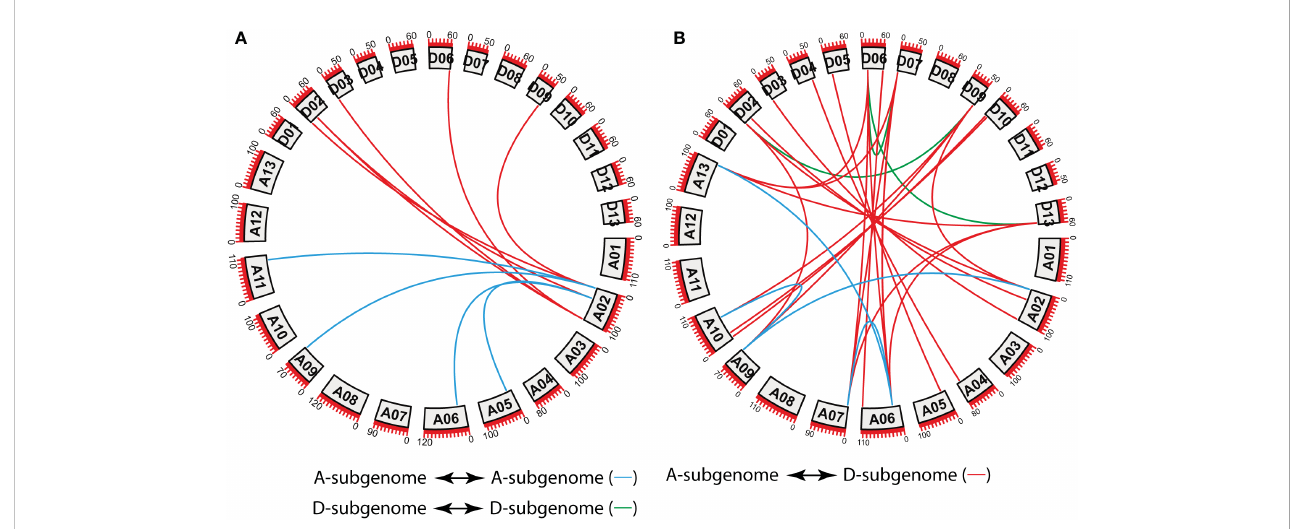
FIGURE 3 Collinearity analysis of G . hirsutum and G . barbadense SAC genes. (A) Collinearity analysis of G . hirsutum SAC genes. (B) Collinearity analysis of G. barbadense SAC genes. A01 to A13 represents A-subgenome chromosomes while D01 to D13 represents D-subgenome chromosomes. Homologous gene pairs between A- to A-subgenome were represented with blue lines, homologous gene pairs between A- to D-subgenome were represented with red lines, and homologous gene pairs between the D- to D-subgenome were represented with green lines.